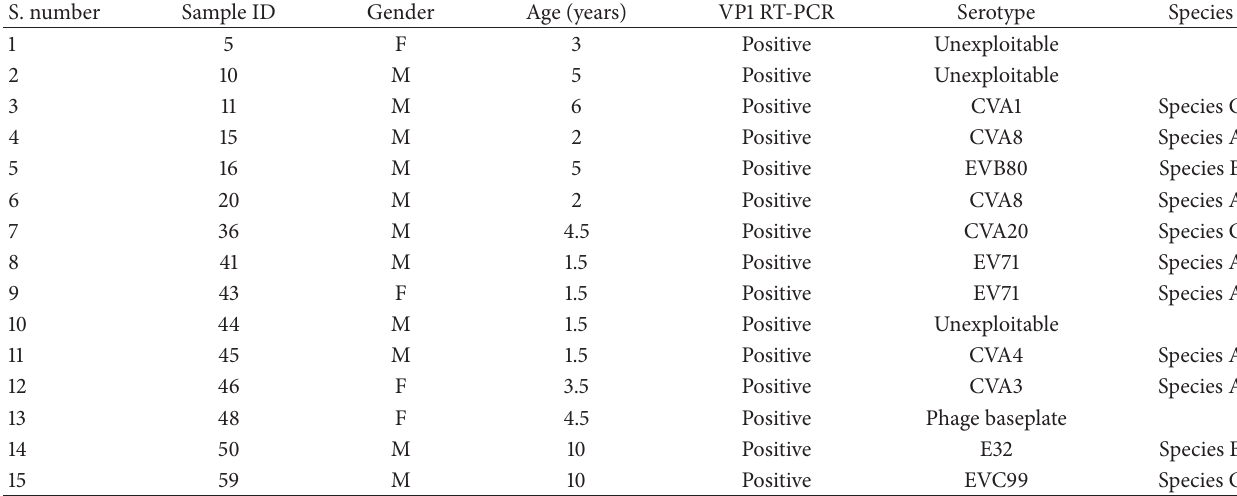
Table 1: Samples positive for the enterovirus VP1 nested RT-PCR screen and the identity of enteroviruses detected in these samples. S.